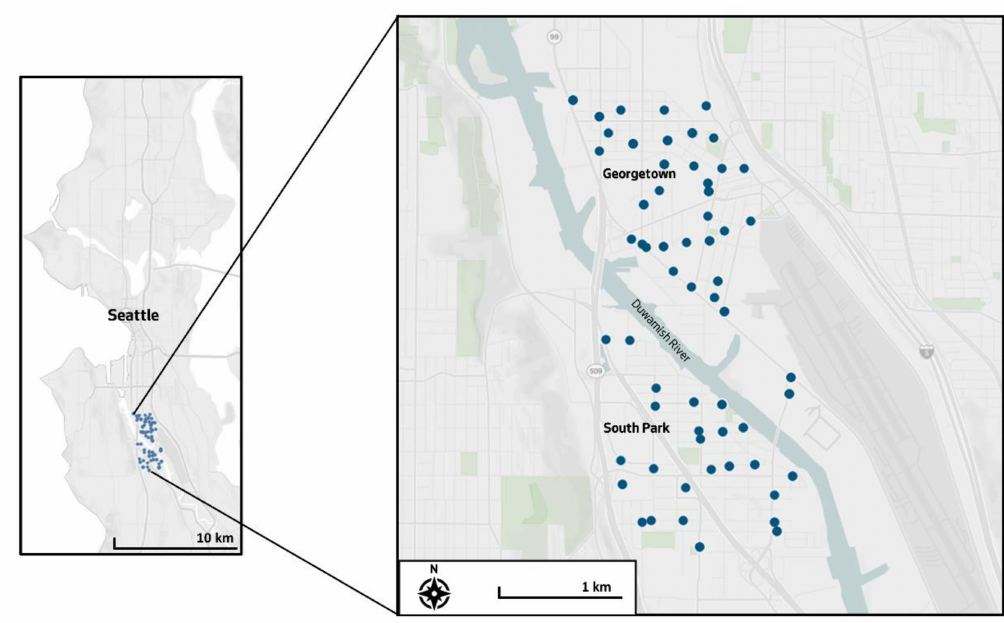
Figure 1. Map of the study area including the neighborhoods of Georgetown and South Park in Seattle, WA. Circles indicate moss sampling locations.